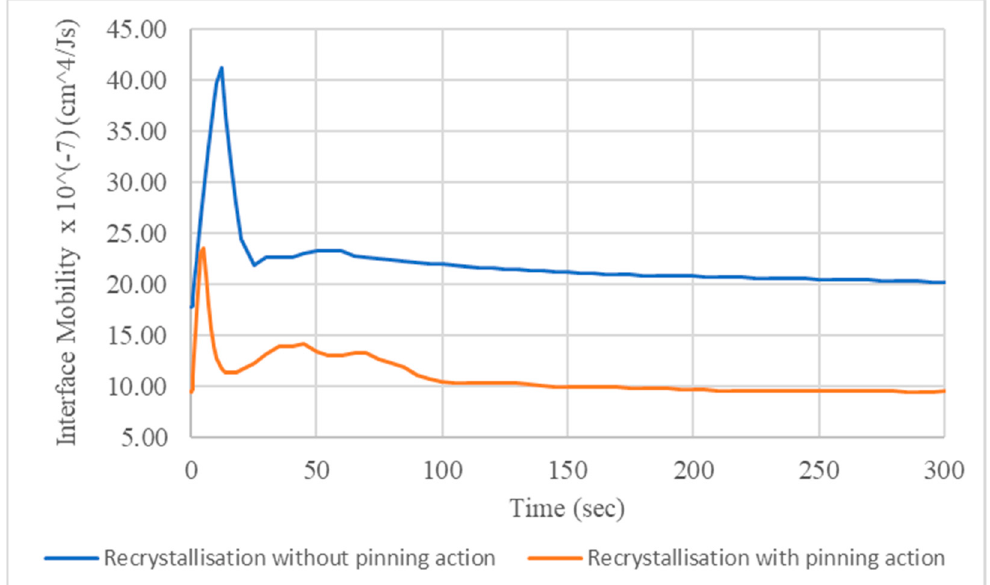
Figure 5. Evolution of the number of grains during the simulation.